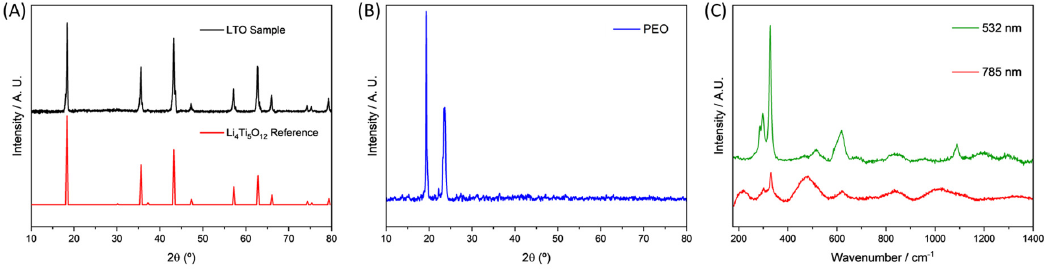
no. 49 ‐ 0207); ( B ) XRD pattern of the PEO; ( C ) Raman spectra taken of a cleaned lithium metal sur ‐ face using a 532 nm (green) and a 785 nm (red) wavelength laser.